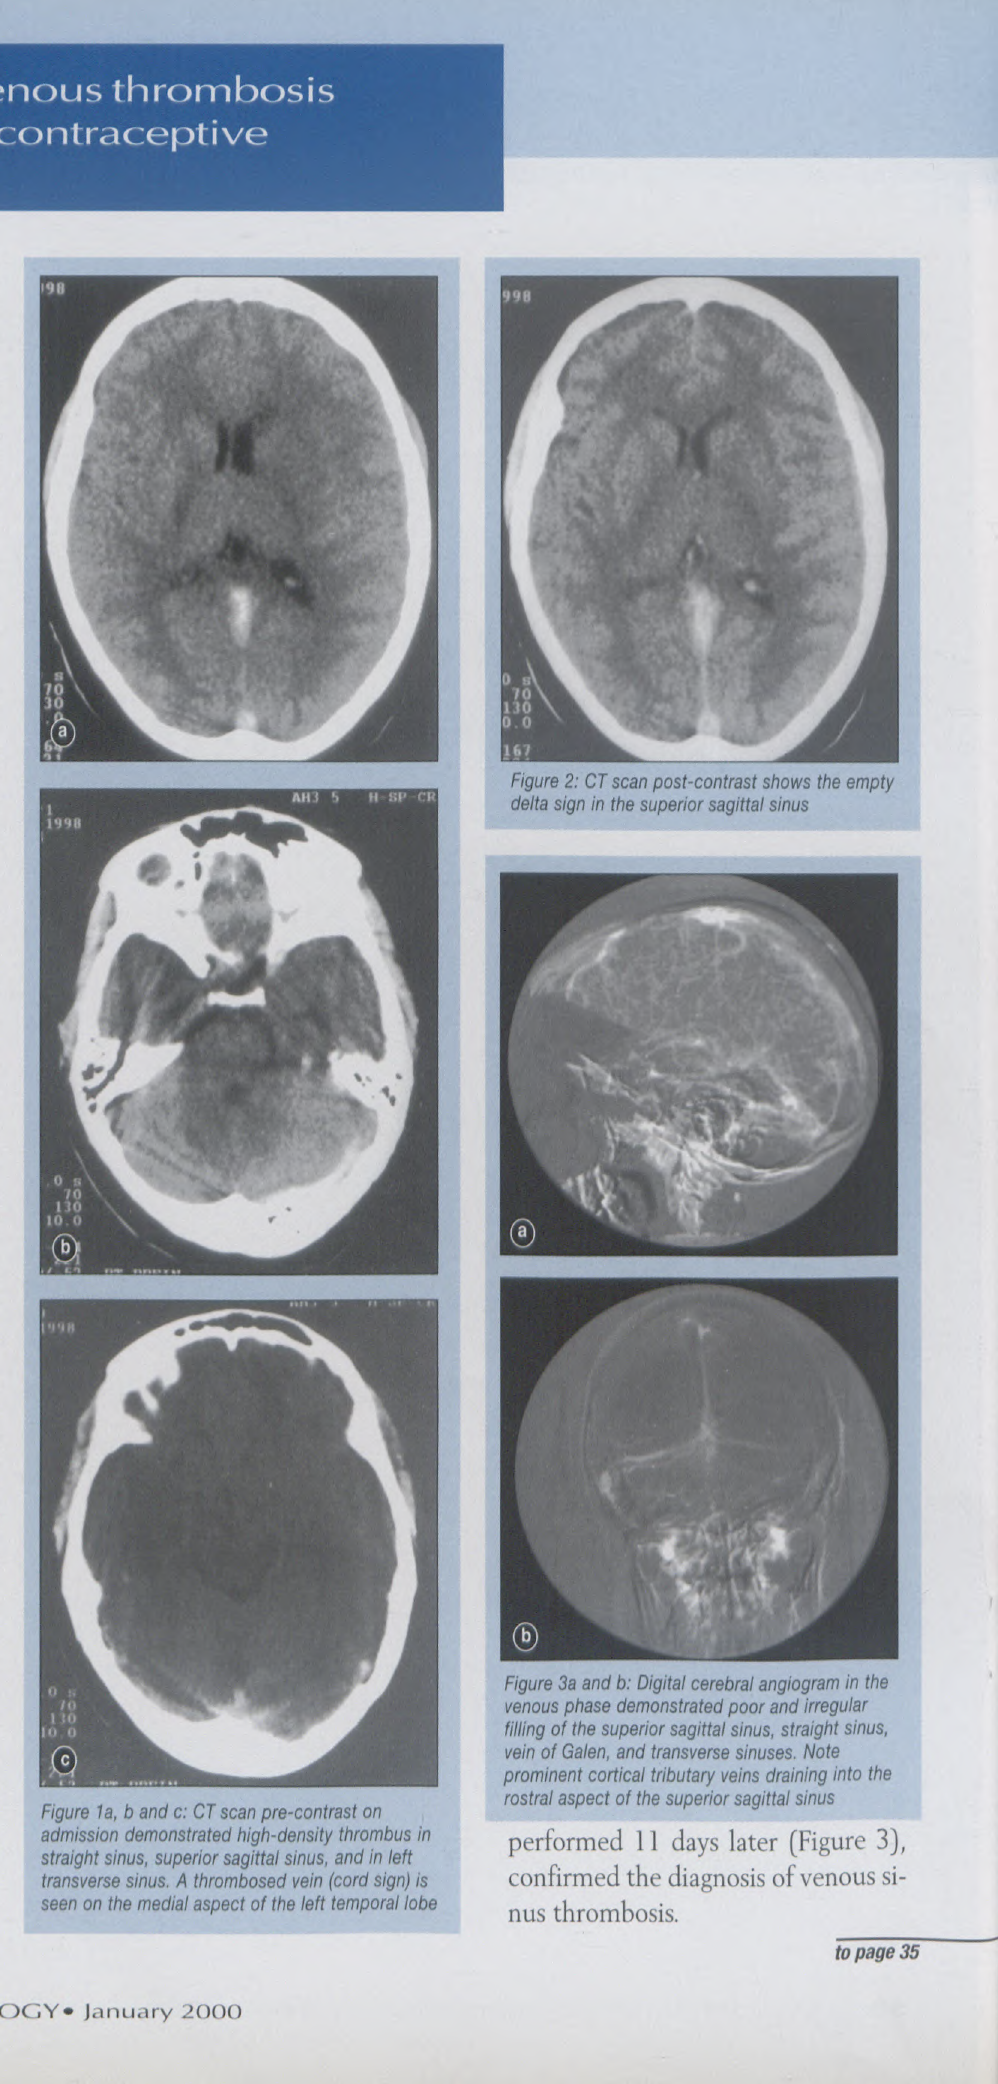
Figure 1 a, band c: CT scan pre-contrast on admission demonstrated high-density thrombus in straight sinus, superior sagittal sinus, and in left transverse sinus. A thrombosed vein (cord sign) is seen on the medial aspect of the left temporal lobe